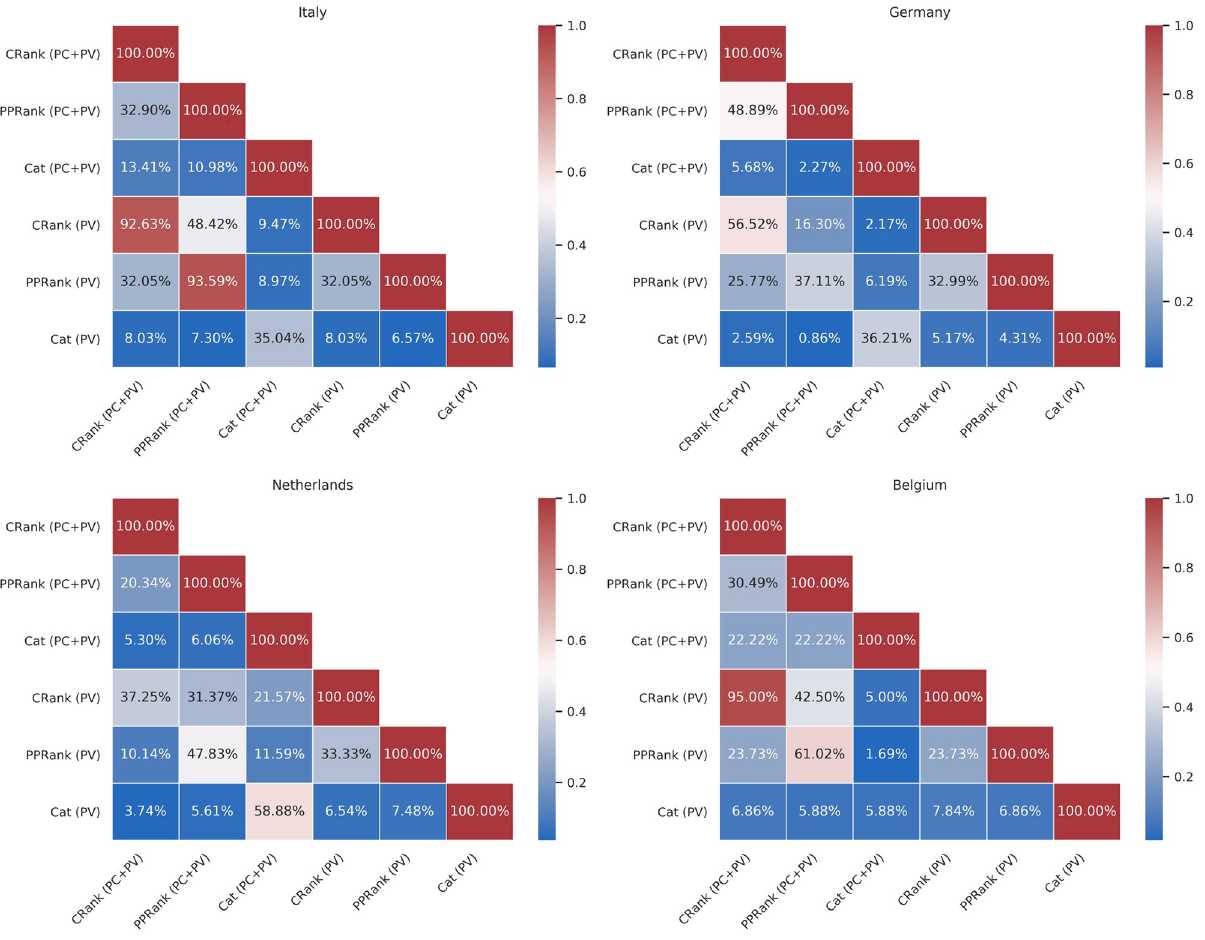
Fig 3. Percentage of features shared by each LASSO model (CRank = CycleRank , PPRank = PPageRank , Cat = Categories ), trained with the two different dataset ( PV and PC+PV ). We recorded all the features selected by each model for each influenza season (a feature was included if its weight in at least one model was different from zero). Then, we computed the intersection between each set of features for each combination model/dataset.